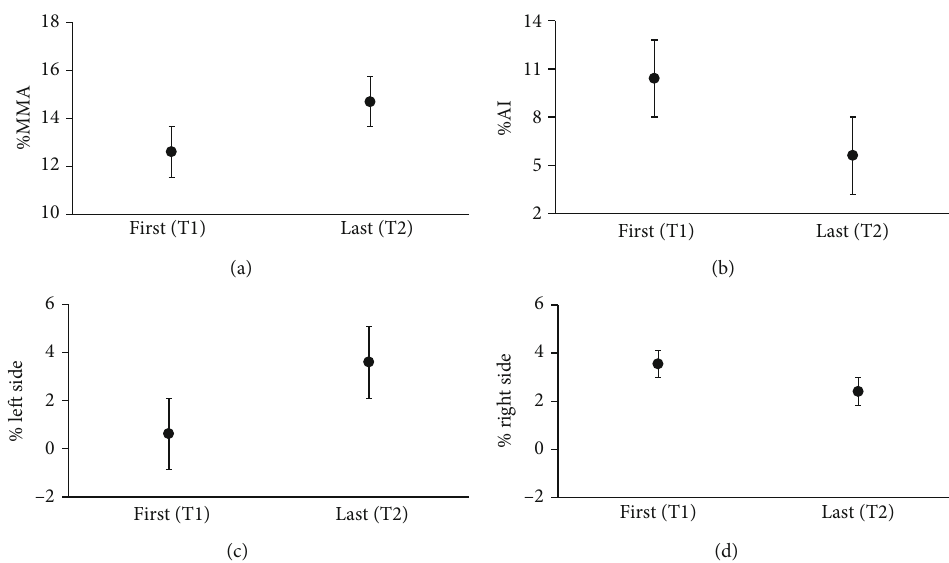
Figure 5: The graphs show the results of the bilateral analysis between the fi rst (T1) and the last acquisition (T2). The parameters considered were (a) %MMA (the maximum Euclidian distance in millimeters between the two lip corner markers), (b) %AI (asymmetry index), (c) % left side (the Euclidian distances in millimeters between the left lip corner marker and the nose marker), and (d) right side (the Euclidian distances in millimeters between the right lip corner marker and the nose marker). Error bars represent SE (standard errors of the means).